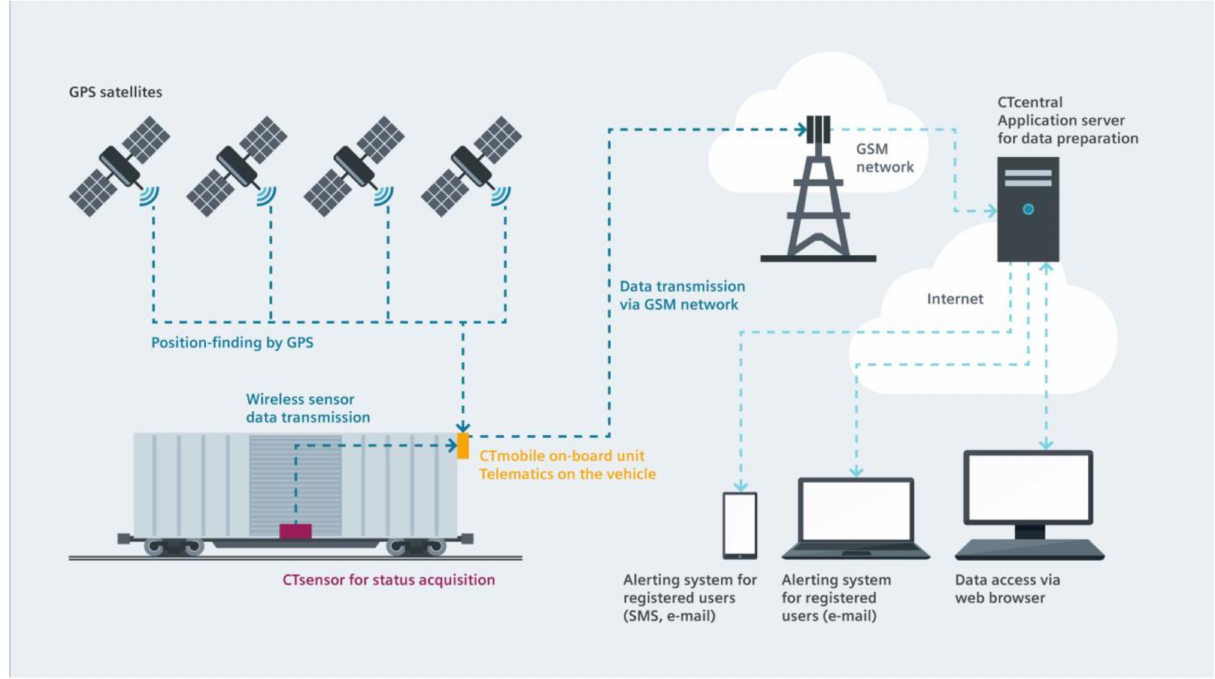
Figure 1. Telematics system in rail